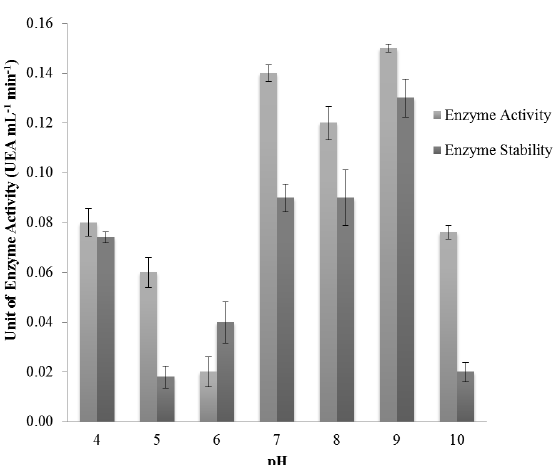
Figure 1 - Evaluation of crude extract and purified CMCase activity face to a temperature range of 30-80ºC after 30 minutes of